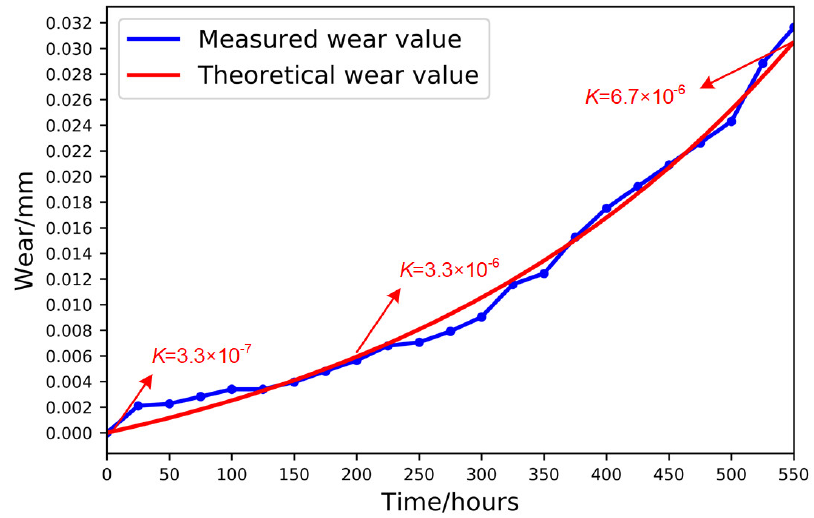
Figure 15. Accumulated wear value of ball screw during accelerated degradation test (ADT).